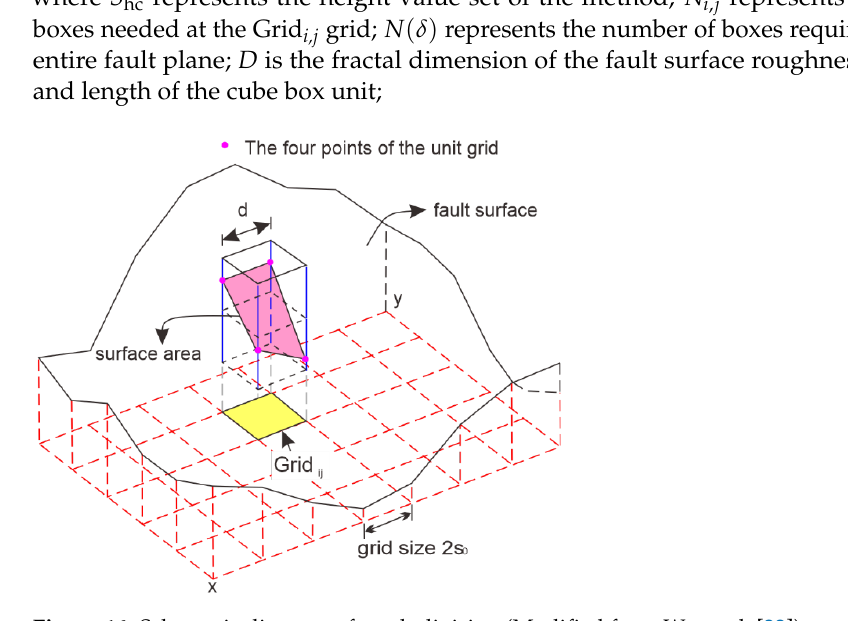
Figure 16. Schematic diagram of mesh division (Modified from Wu et al. [22]).